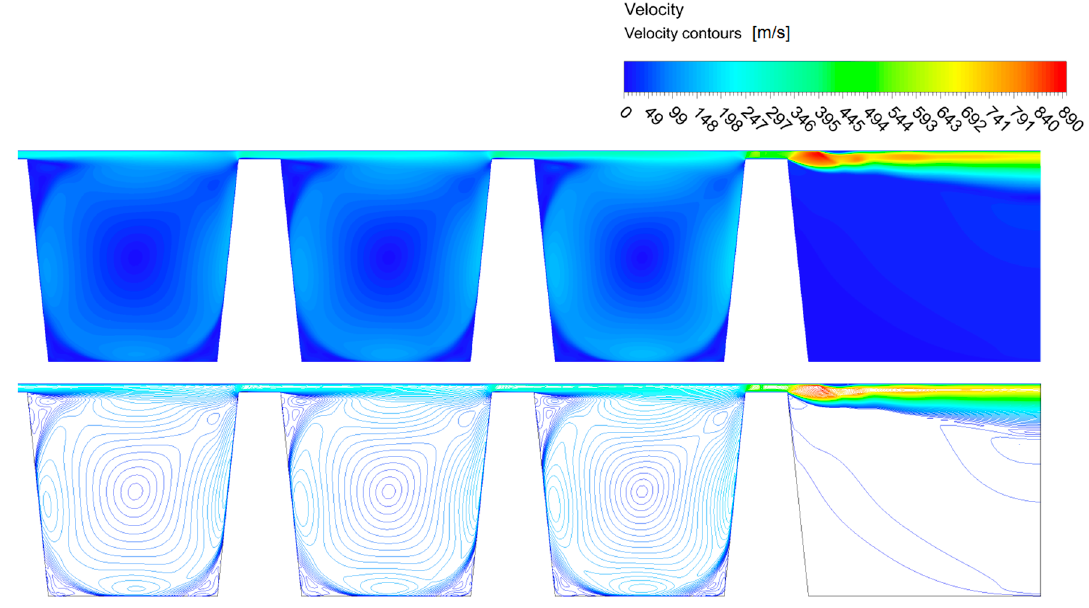
Figure 9: one-sided straight labyrinth Figure 10: tooth-interlocking labyrinth with 1 mm (top), 2 mm (middle) and 3 mm (bottom) basis thickness Figure 11: stepped labyrinth